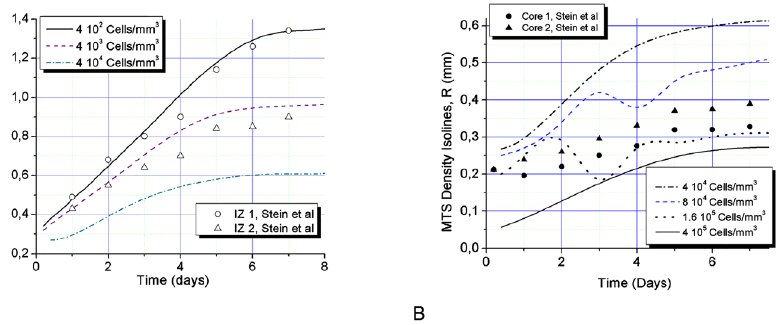
Figure3: IsolinesofcellconcentrationsobtainedinsimulationoftheexperimentalconditionsofStein ’ setal.[68];(A)Solidblack line corresponds to cell concentration of 400 cells/mm 3 , dashed line – 4 × 10 3 cells/mm 3 , dashed-dotted line is for 4 × 10 4 cells/ mm 3 and presentson both graphs (A) and (B); open circlesshow experimental data obtainedby Stein et al. for U87WT glioma cell line ( C IZ1 = 10 4 cells/mm 3 ), open triangles – the results for U87 Δ EGFR cells ( C IZ2 = 2.5 10 3 cells/mm 3 ); (B) solid black line denotes equilibriumcelldensityinthemodel C eq =4 × 10 5 cells/mm 3 ,dottedlinecorrespondsto theconcentrationof 1.6 × 10 5 cells/mm 3 , blue dashed – 8 × 10 4 cells/mm 3 and dash-dotted – 4 × 10 4 cells/mm 3 ; circles and triangles show the core boundary isolines